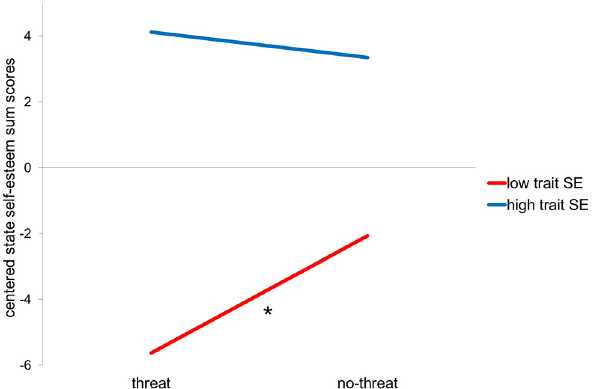
Fig 2. Regression plot of the manipulation check analyses. Centered SSES sum scores as the criterion (y-axis), the performance feedback condition as the predictor (x-axis) and separated by continuous trait self- esteem scores as the moderator (levels are calculated automatically as ± 1 SD below and above mean). * Significance was tested on a p < .05